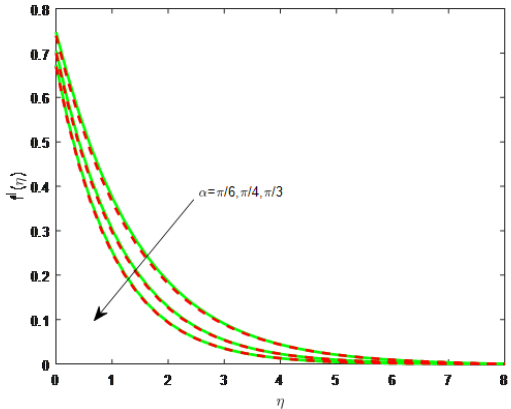
Fig. 5: Influence of α on velocity field